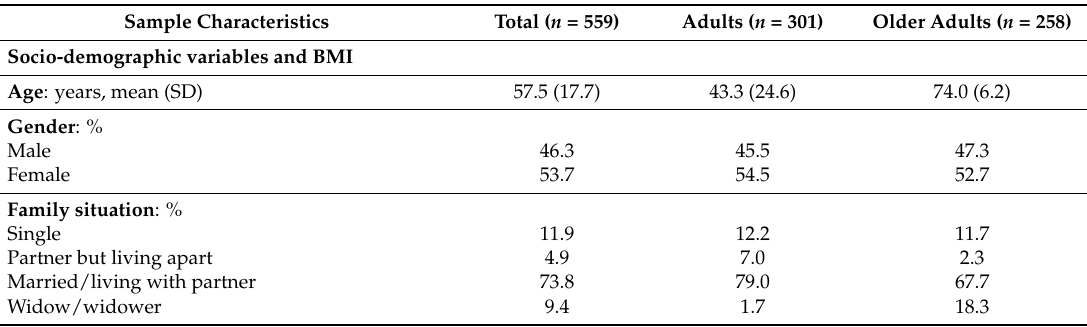
Table 1. Sample characteristics from the study